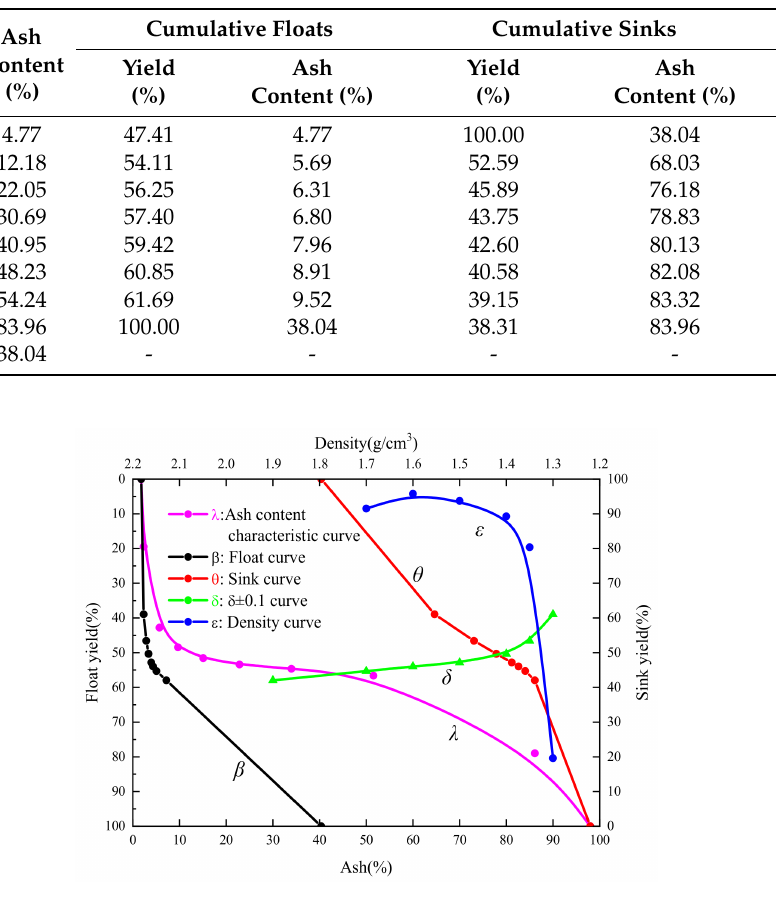
Figure 2. Washability curves of 6–0.5 mm